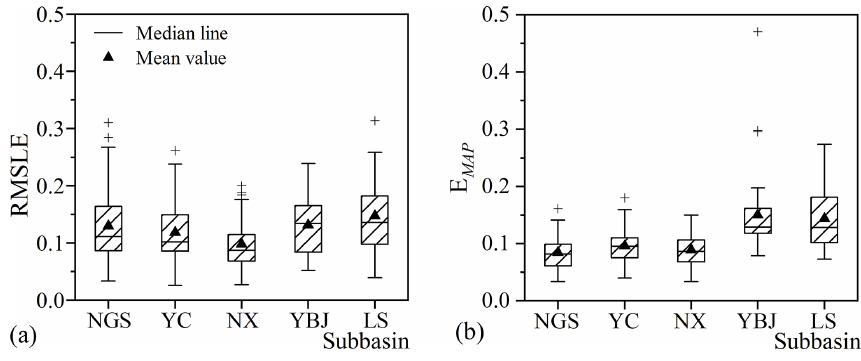
Figure 6. The box plot of (a) the RMSLE of − d Q/ d t between observed and estimated discharge and (b) E MAP between annual mean observed and estimated discharge for individual recession hydrographs in each